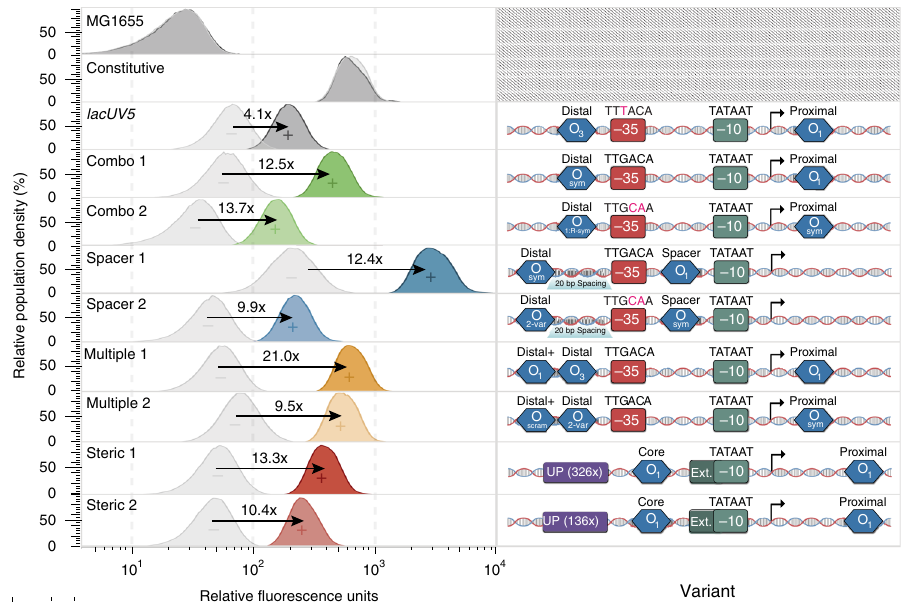
Fig. 5 Characterization of functional inducible variants using a fl uorescent reporter. Fluorescence measurements of selected variants for induced and uninduced states determined using fl ow cytometry. Fold change of each variant was estimated after background subtracting induced and uninduced expression. “ − ” represents the promoter in an uninduced state while “ + ” represents induction after 1 mM IPTG. Source data are available in the Source Data fi